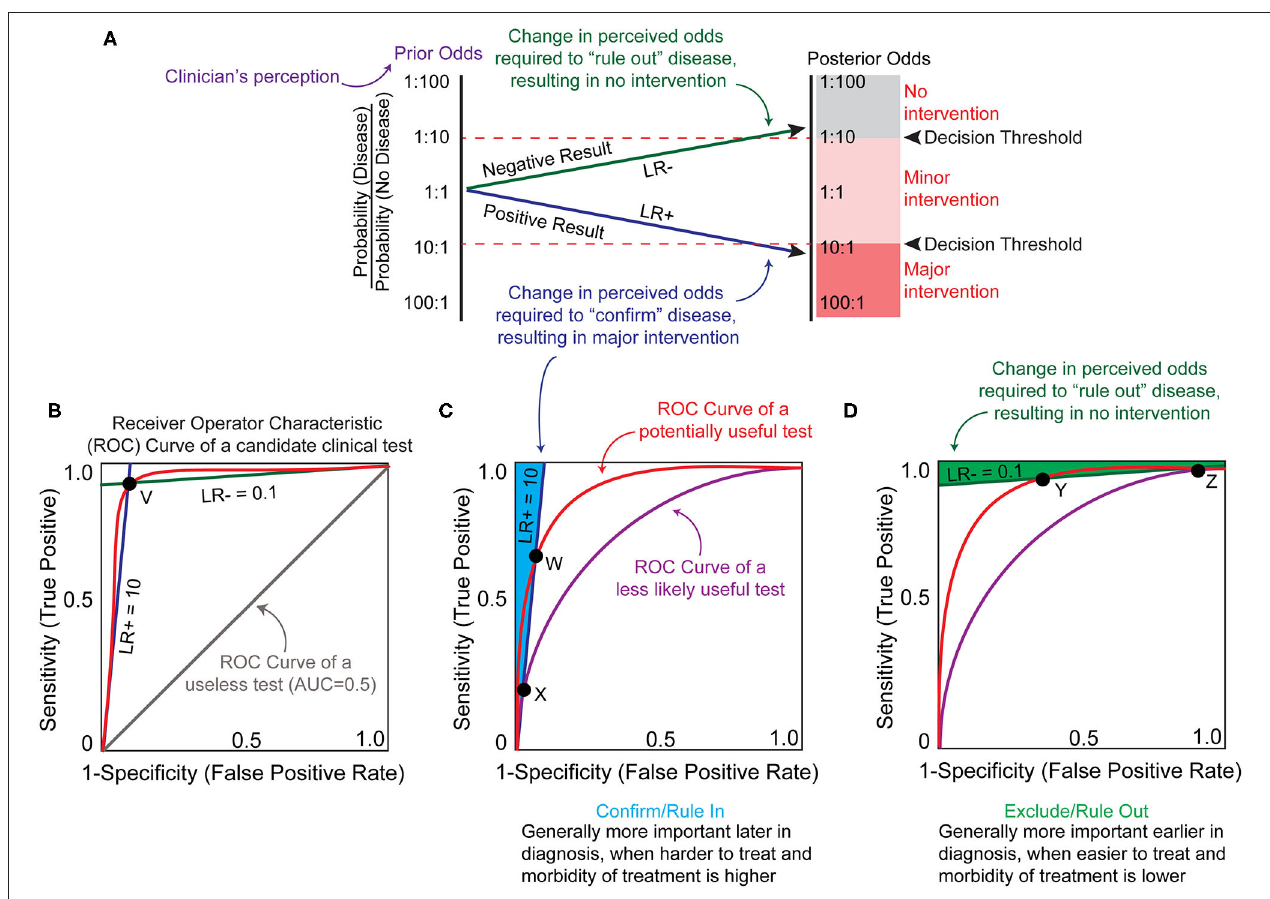
FIGURE 2 | Theoretical framework for biomarker utility analysis. (A) A clinician may be challenged with a state of uncertainty, where the perceived probability of the disease (prior odds, purple) does not surpass the clinician’s personal thresholds for recommending either major intervention or no intervention (decision thresholds, red dotted lines). A clinician may hope to reduce uncertainty based upon a biomarker test result. A positive result must alter the probability of the disease sufficiently to breach the decision threshold to recommend major intervention (blue line). A negative result must alter the probability of the disease sufficiently to breach the decision threshold to recommend no intervention (green line). In this example, the prior odds are an equal probability of disease or no disease. Based upon this clinician’s decision thresholds, an actionable biomarker test result would require either a 10-fold increase or 10-fold decrease in this perceived probability (posterior odds). The extent by which a biomarker test might change the perceived odds can be calculated as a likelihood ratio (LR). A positive LR (LR + , blue line) increases the likelihood of the disease state being present and a negative LR (LR–, green line) decreases the likelihood of the disease state being present. The posterior odds following a biomarker test can be calculated as the prior odds multiplied by the likelihood ratio. (B) LR + and LR– can be plotted against sensitivity and specificity on the axes of a receiver operator characteristic (ROC) curve graph, which represents the sensitivity and specificity of the test at different cut-off values where an “abnormal” result flag would be generated (red curved line). The LR values represent the slope at any given point on the ROC curve, and the LR lines for point V are represented. The area under the ROC curve (AUC) describes the overall sensitivity and specificity of a test at all cut-off points. AUC of 1.0 represents 100% sensitivity and specificity, and a useless test (gray line) has an AUC of 0.5. The red ROC curve has an approximate AUC of > 0.9. (C) In the example shown in (A) , a minimum LR + of 10 is required to generate posterior odds that breach the clinician’s decision threshold for major intervention. The area (shaded in light blue) left of this LR + slope (dark blue line) represents the sensitivity and specificity characteristics of a test useful for confirming or ruling in a disease state that has an LR + ≥ 10. A biomarker test with performance represented by the red ROC curve has a greater range of cut-off values that can produce an LR + ≥ 10, and has a higher maximal potential sensitivity (point W) compared to the purple ROC curve (point X). This translates to a greater odds of achieving a true test value that has the potential to change the clinician’s decision for the red ROC curve, especially with test cut-off values at point W. (D) Similar to (C) , the area (shaded in green) above the LR– slope (dark green line) represents the sensitivity and specificity characteristics of a test useful for excluding or ruling out the example disease state from (A) . The red ROC curve represents a hypothetically useful test with a higher maximal sensitivity capable of achieving a LR– ≤ 0.1 (point Y), and the purple ROC curve represents a test that is less likely